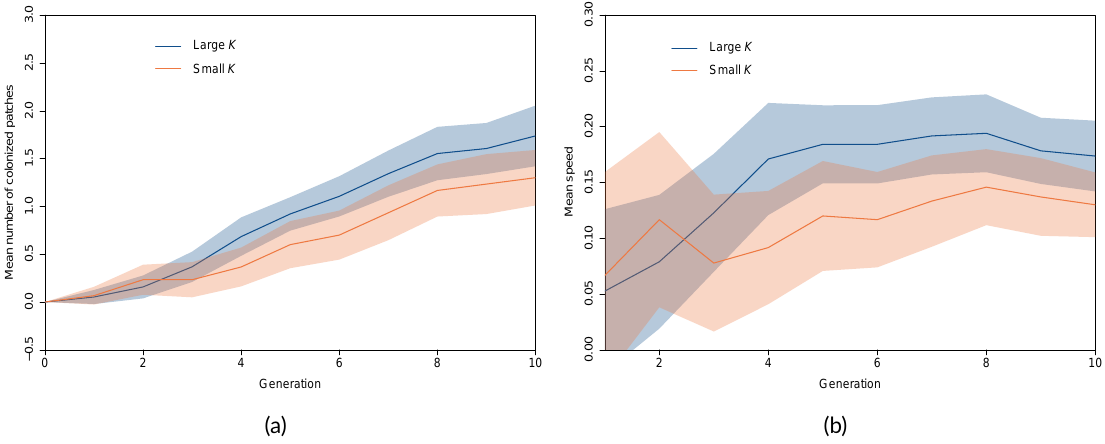
Figure 5 – Mean number of colonized patches for the 68 replicate fronts over 10 gen- erations (a); and corresponding mean speed (b). The red line corresponds to the small carrying capacity 150-200 host eggs, and the blue line corresponds to the large carry- ing capacity 400-450 host eggs. The red envelope is the 95% confident interval for the small modality and the blue envelope is 95% confidence interval for the large carrying